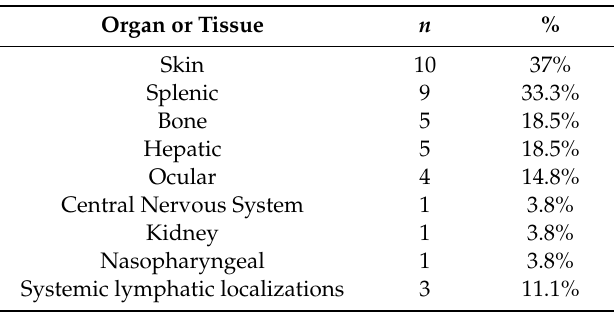
Table 4. Extra-thoracic localizations.